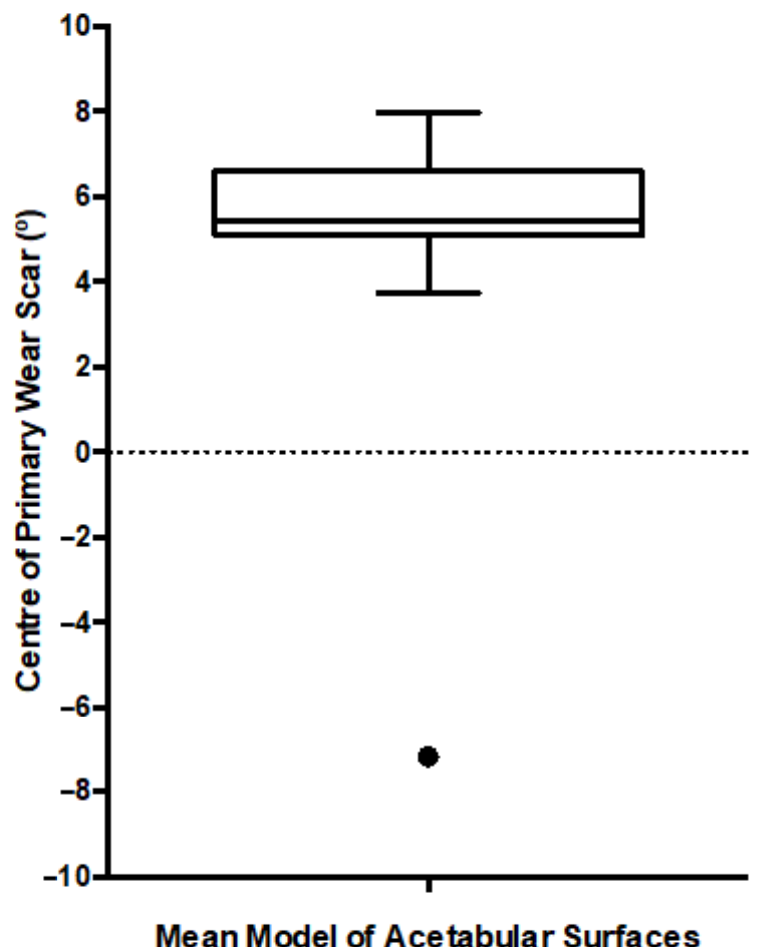
Figure 5. Box and Whiskers plot presenting the location of the primary wear scar centre, measured after each iteration of the leave-one-out study. The median is presented along with the range (min- max) and interquartile range. The black dot represents the single outlier.